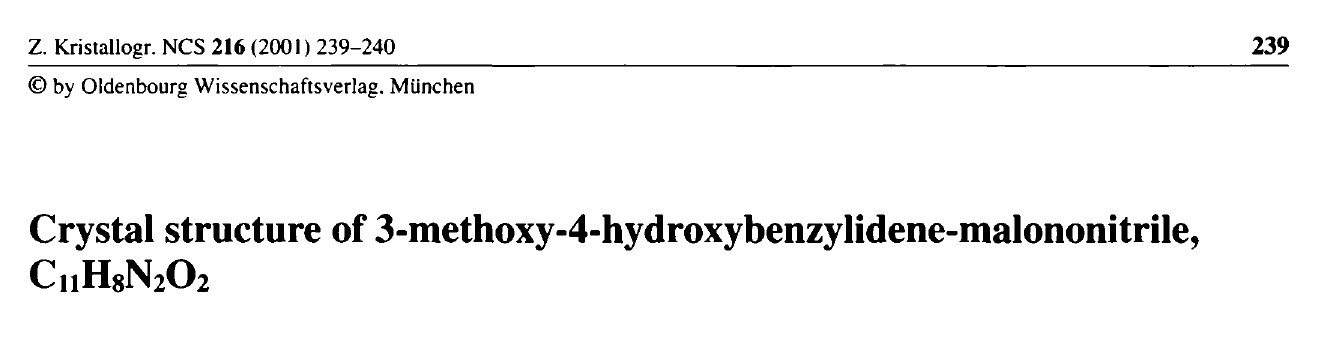
Table 1. Data collection and handling.